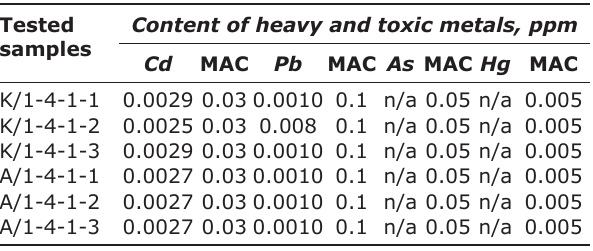
Table-1: Data regarding the content of toxic heavy metals in cow milk from basic farms in the Almaty region. Tested samples